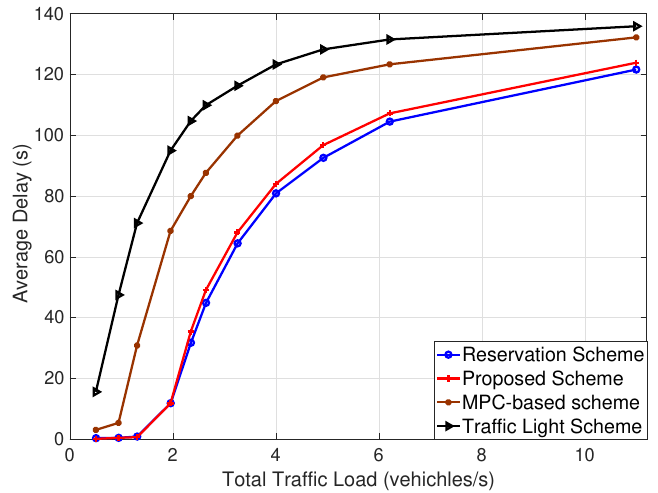
Figure 6. Average delay comparison under different schemes.